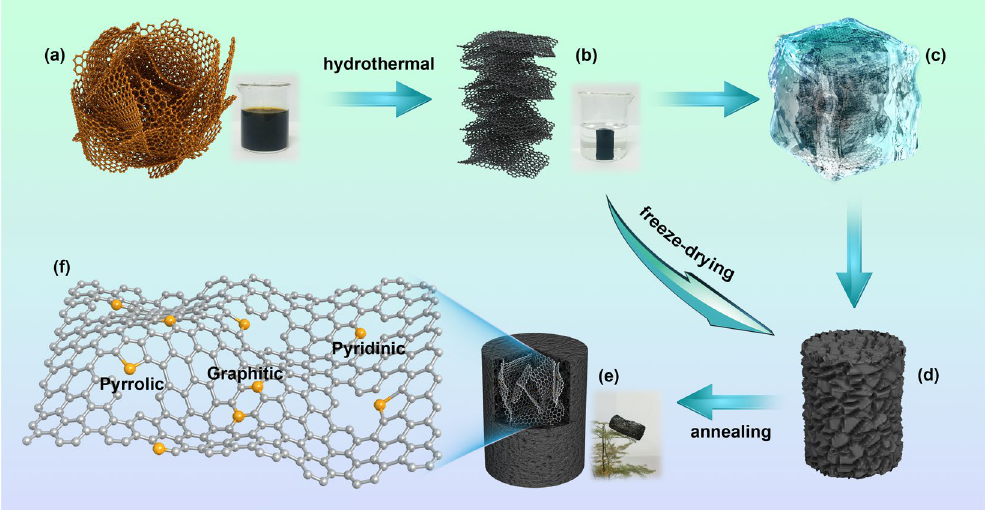
Figure 1. Schematic illustration of synthesis steps for the N-doped graphene aerogel: ( a ) photographic images of graphene oxide suspension (5 mg mL − 1 ), ( b ) freeze-dried graphene hydrogel obtained after hydrothermal reaction, ( c ) freeze-drying treatment, ( d ) 3D graphene aerogel, and ( e ) N-doped graphene aerogel. ( f ) Schematic illustration of a N-doped graphene aerogel sheet with three nitrogen doping